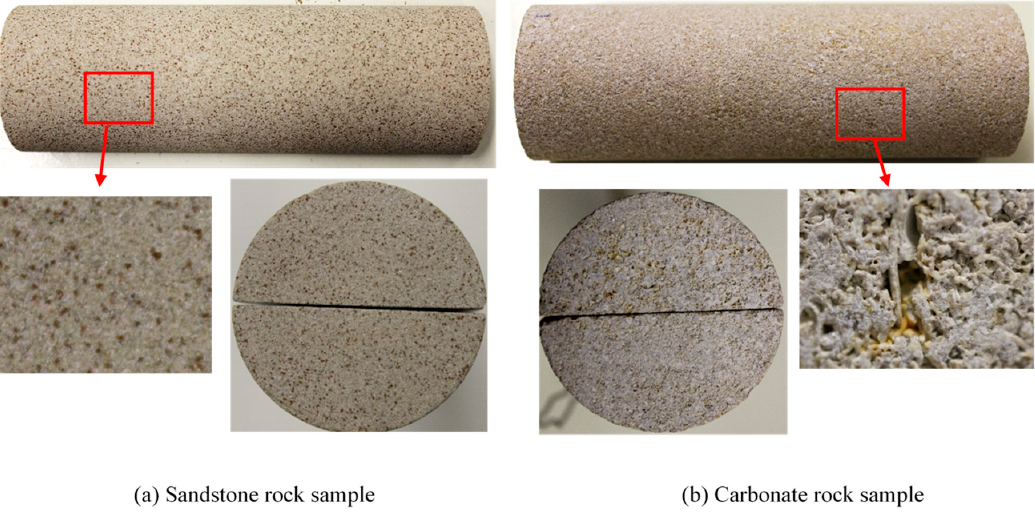
Figure 1. Images of rock samples used in this study. ( a ) Left: sandstone rock sample having a relatively homogeneous matrix. ( b ) Right: carbonate rock sample with heterogeneous matrix and vuggy porosity.